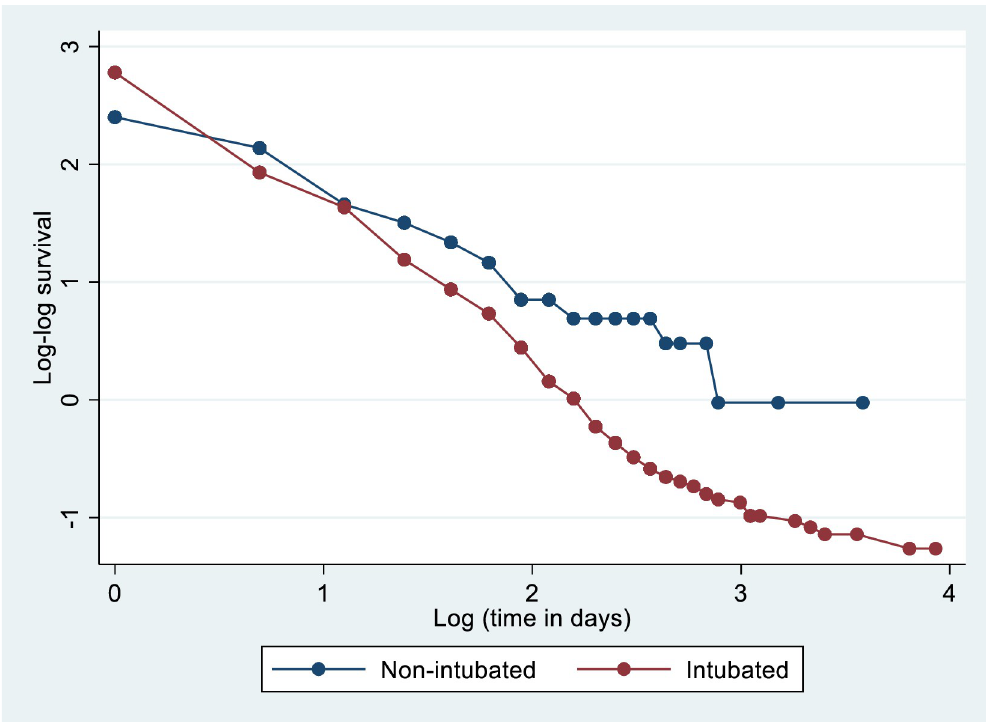
Fig 3. Log-log plot of survival of COVID-19 patients admitted to ICU to assess the assumption of proportional